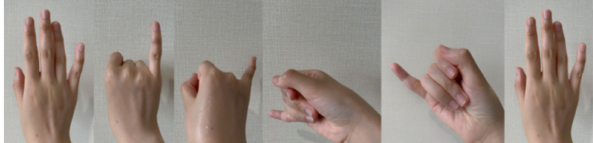
Figure 2. Dynamic process of sign “j”.